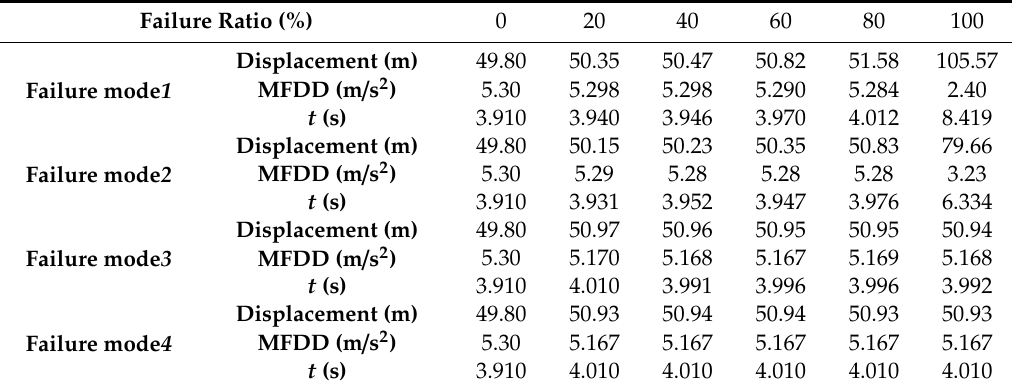
Table 7. Simulation result at di ff erent failure